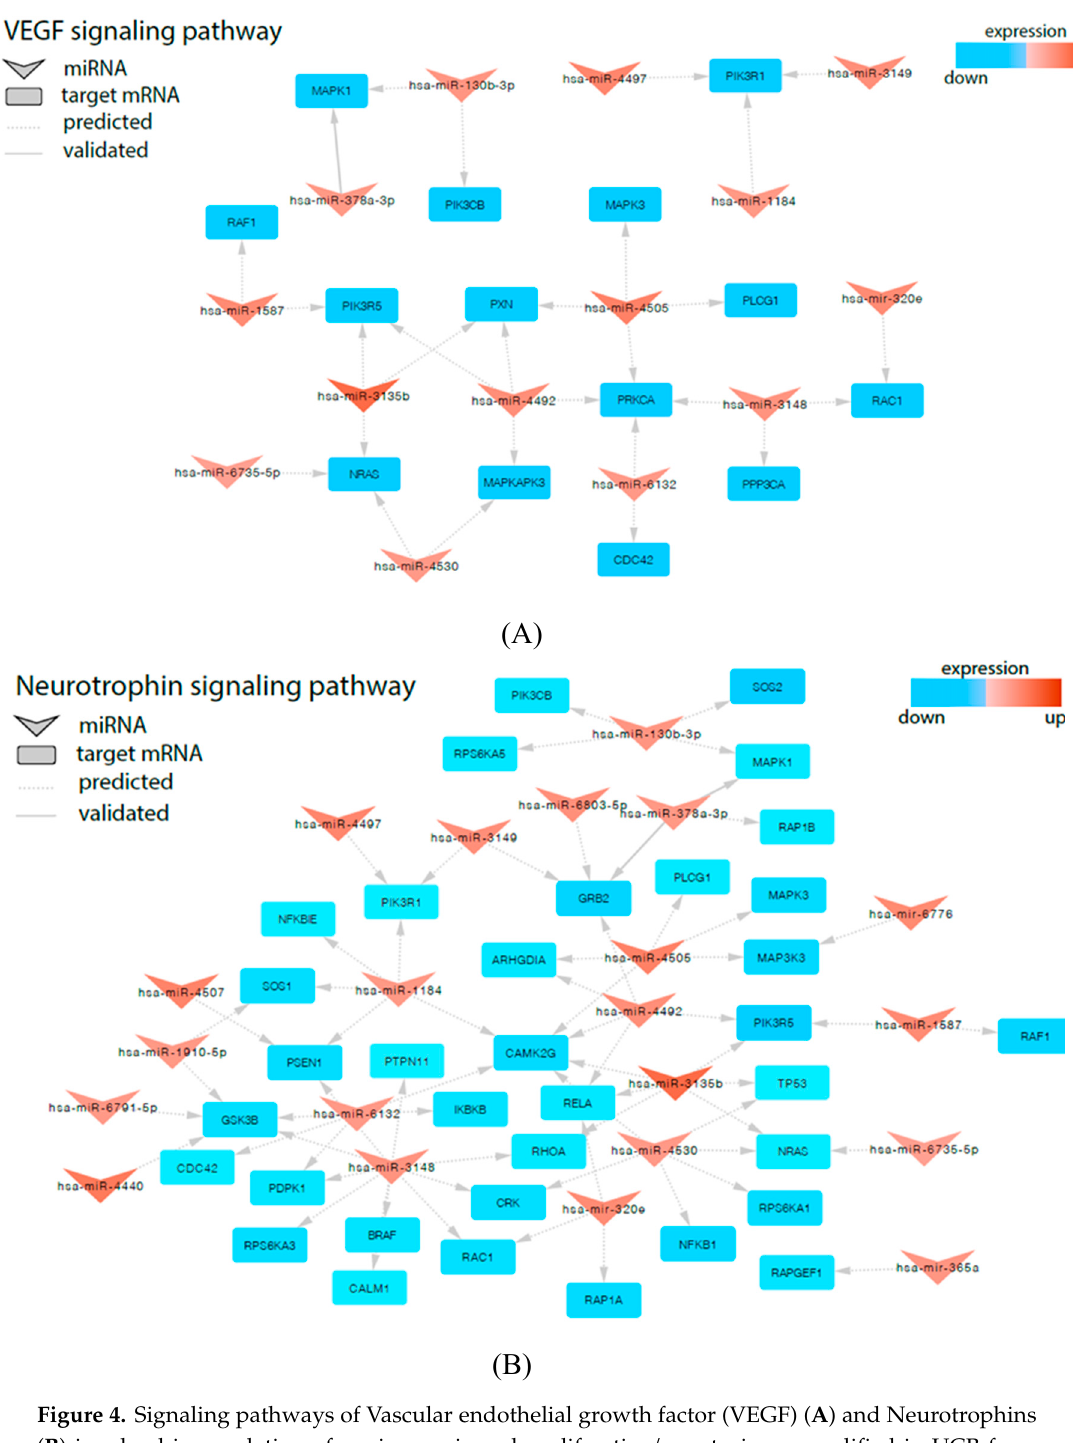
Figure 4. Signaling pathways of Vascular endothelial growth factor (VEGF) ( A ) and Neurotrophins ( B ) involved in regulation of angiogenesis and proliferation/apoptosis are modified in UCB from newborns from preterm labor. The arrowheads represent differentially expressed miRNAs and the squares represent negatively regulated genes.